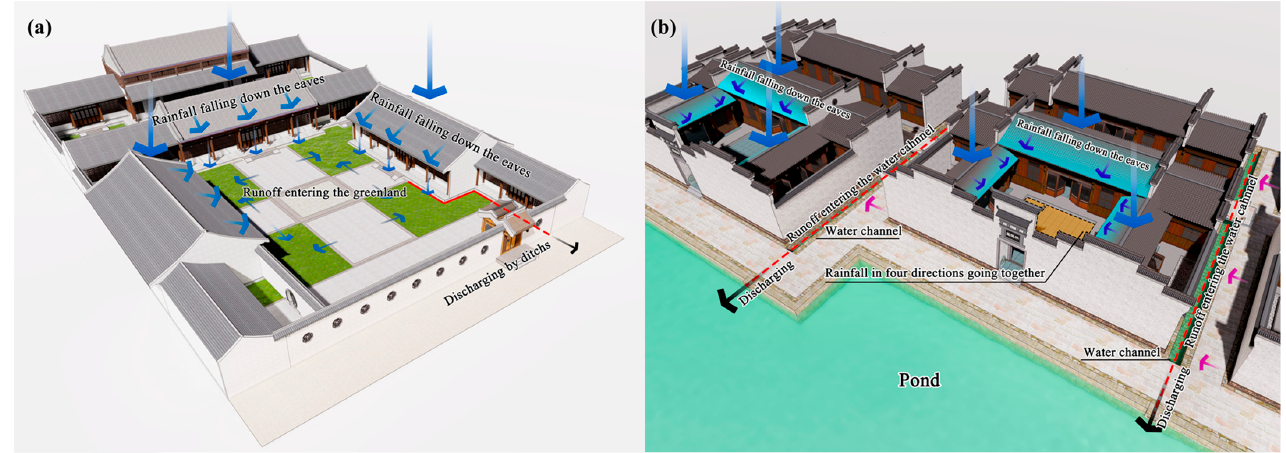
Figure 1. Drainage systems in ancient southern and northern China: ( a ) Typical courtyard buildings in northern China; ( b ) Ancient villages in southern China.